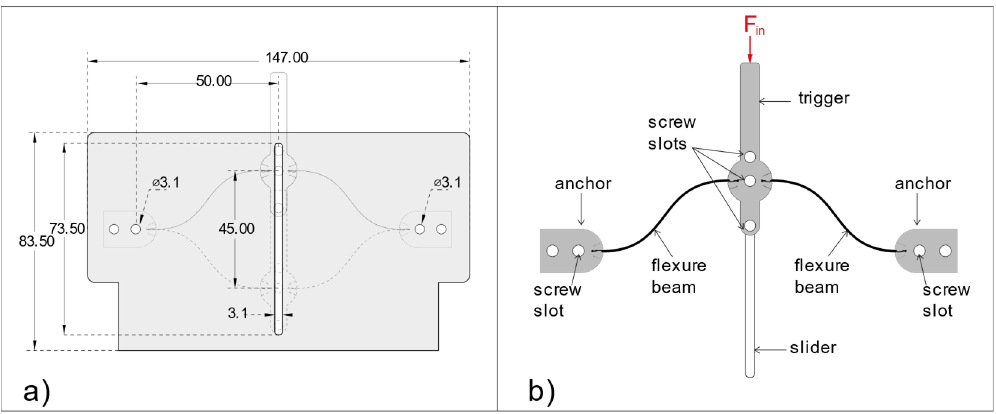
Figure 2. ( a ) Design and dimensions of the base of the setup. The layout of the flexure beams and components can be seen in thin lines. ( b ) Schematic of the components of the bi-stable mechanism.